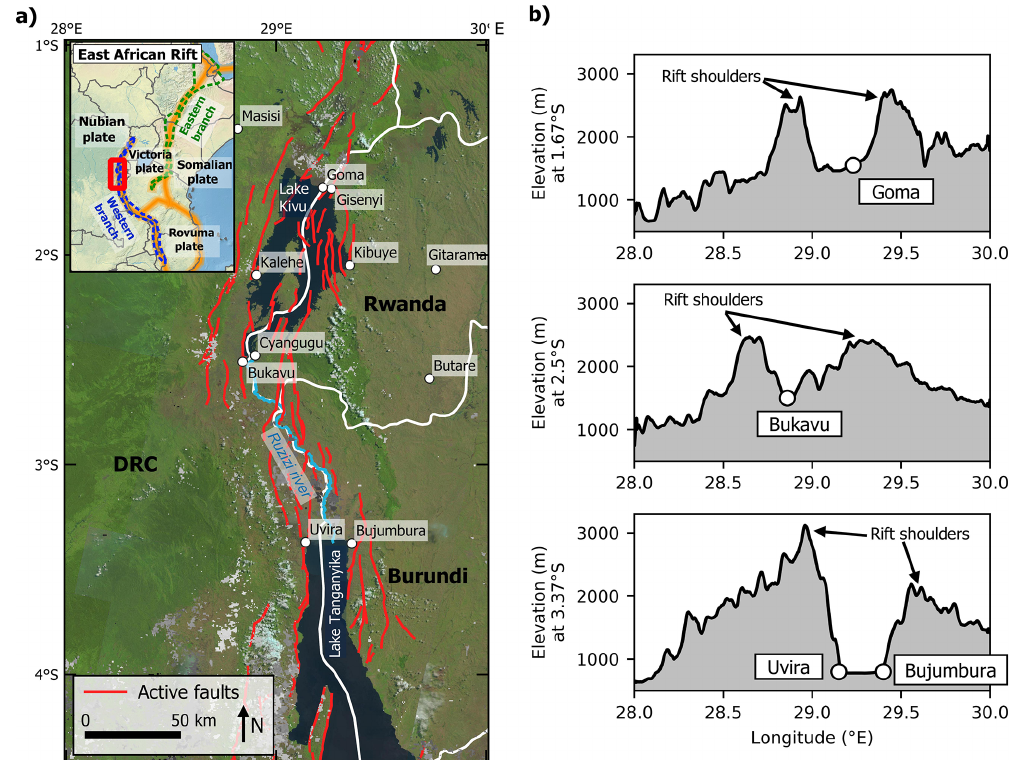
Figure 1. Overview of the North Tanganyika–Kivu (NTK) rift. (a) Extent of the studied area and active faults (Delvaux and Barth, 2010). LANDSAT-8 imagery is used as background (USGS, 2018). (b) The transects of the elevation at different latitudes illustrate the elevated rift shoulders, being the result of tectonic uplift. The four most populous cities in the area of the NTK rift (Goma, Bukavu, Uvira, Bujumbura) are located in between the rift shoulders. The transect was derived from the 30m resolution digital elevation model (DEM) provided by the Shuttle Radar Topography Mission (SRTM) (USGS,